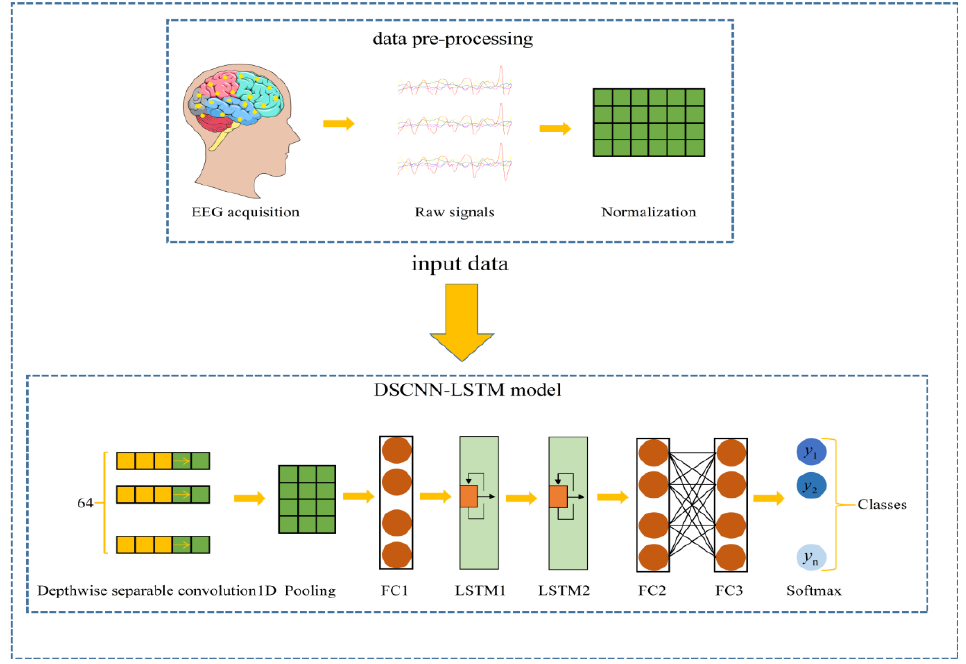
Figure 4. Depthwise separable convolutional neural network and two-layer long short-term memory networks (DSCNN-2LSTMs) model structure. FC is the full connection layer, and y is the classification category. Table 1. Parameters of the DSCNN--2LSTM architecture.